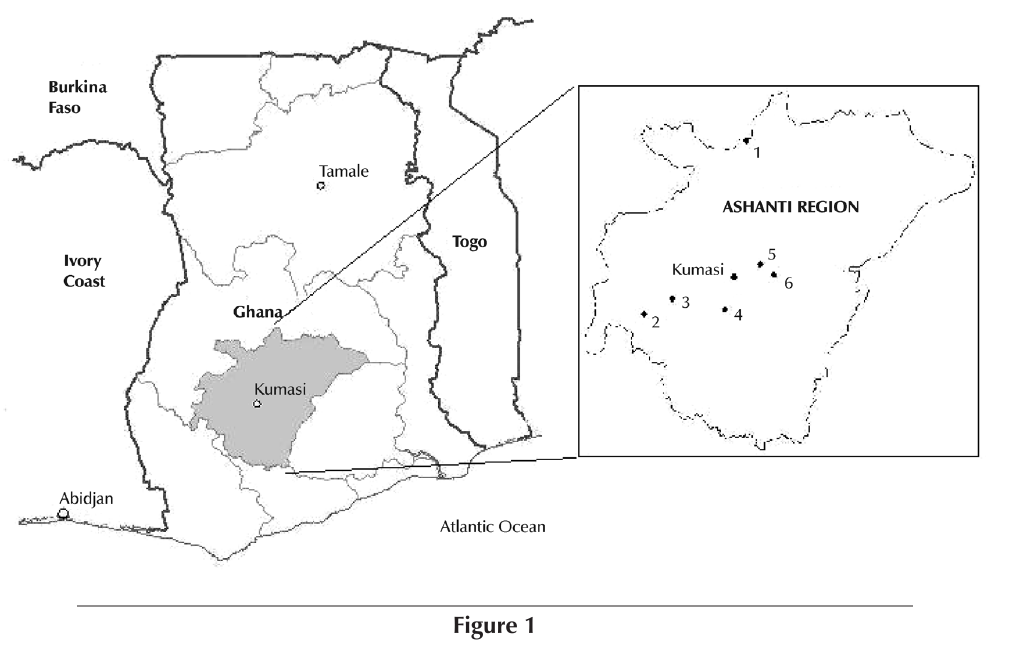
Map showing the location of the study sites. 1= Drobon; 2= Nagode; 3= Pakyi (Nkromma); 4= Pekyi No.1; 5= Asotwe; 6=